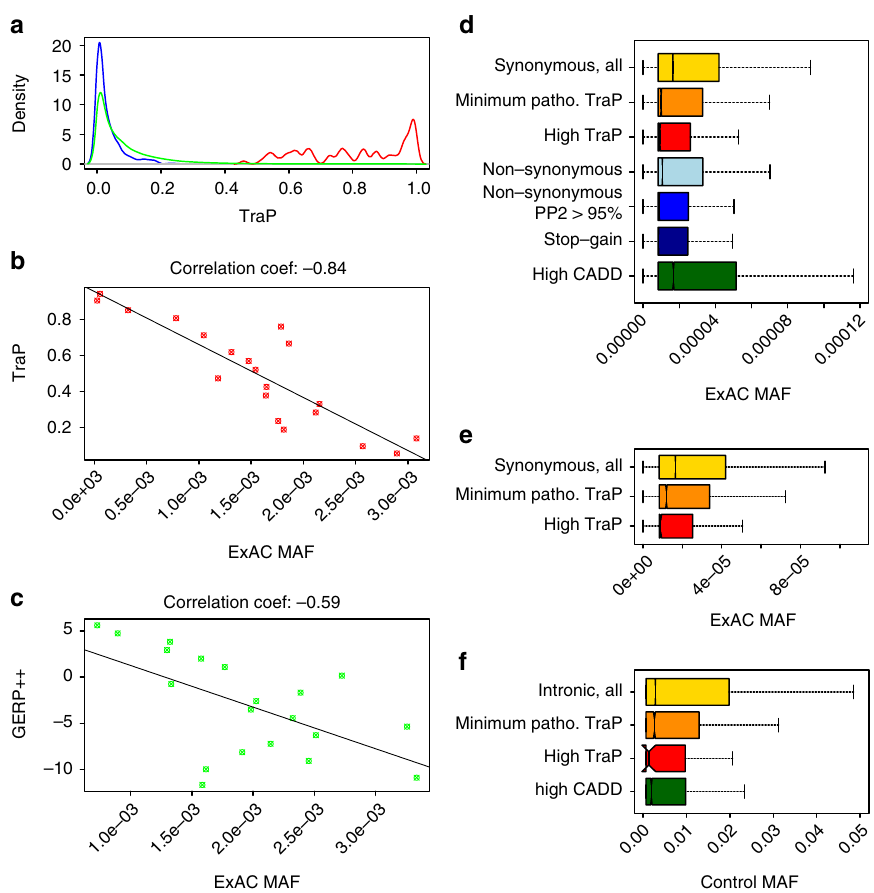
Fig. 2 TraP and allele frequency of synonymous and intronic variants. a TraP density plots for training-set pathogenic variants ( red ), control DNMs ( blue ) and 1.46 M ExAC synonymous variants ( green ). b Correlation between TraP and MAF for 29,985 synonymous variants that create strong cryptic splice sites. The data set was binned into 20 groups by taking 5% score intervals and examining the correlation of the 20 points with the average MAF for each group. c Correlation between GERP++ score and MAF for 29,985 synonymous variants that create strong cryptic splice sites. The data set was binned 20 groups as in ( b ). d MAF distributions for different types of variants. MAF distribution for synonymous variants is presented with no Trap threshold ( yellow ), minimum pathogenic TraP ( ≥ 0.459, orange ) and high TraP ( ≥ 0.93, red ). Synonymous variants with high TraP ( red ), have signi fi cantly lower average MAF than NS variants (bright blue). MAF distribution of CADD top scoring synonymous variants (97.84th percentile) is also presented (green). e MAF distributions based on a non-GERP++TraP model for 1.46 M ExAC synonymous variants. Thresholds used differ from the fi nal TraP model: minimum pathogenic TraP threshold used is the 25th percentile score ( ≥ 0.66, orange ) and high TraP threshold is the 75th percentile score ( ≥ 0.955, red ). f MAF distributions for 1.5 M intronic variants from 776 sequenced whole genomes. MAF distribution is presented for variants with no Trap threshold ( yellow ), minimum pathogenic TraP ( ≥ 0.459, orange) and high TraP ( ≥ 0.93, red ). The whiskers of the boxplots extend to the most extreme data point, which is no more than 1.5 times the interquartile range away from the